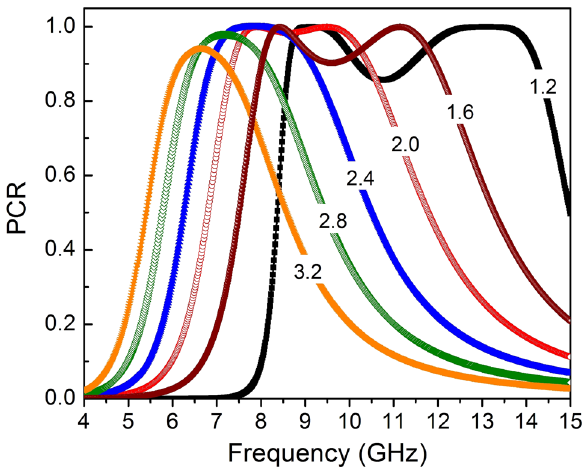
Figure 9. The PCR of the proposed polarization converter as a function of thickness of dielectric layer.